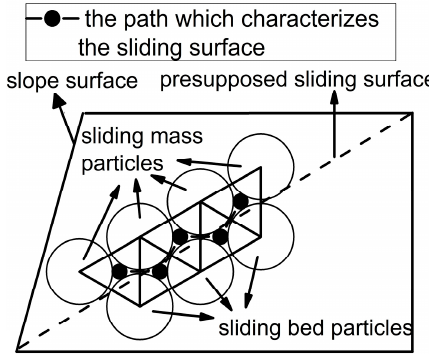
Figure 5. The particle contacts which characterize the sliding surface.